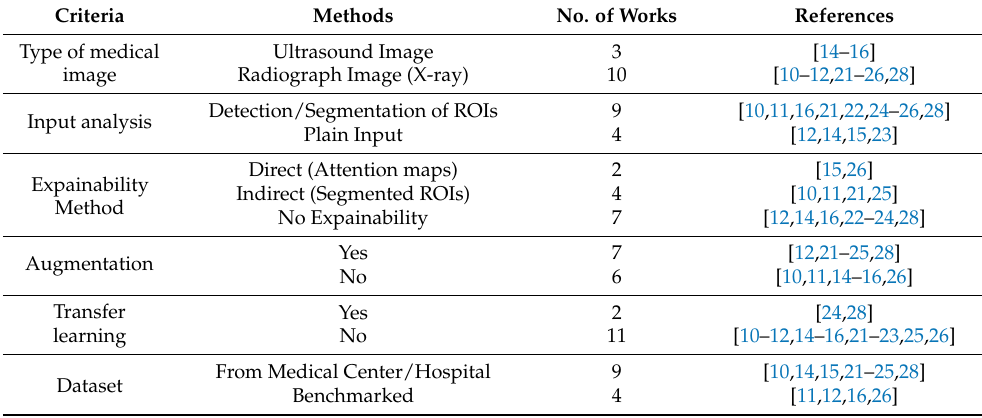
Table 3. Criteria analysis of conducted works based on image